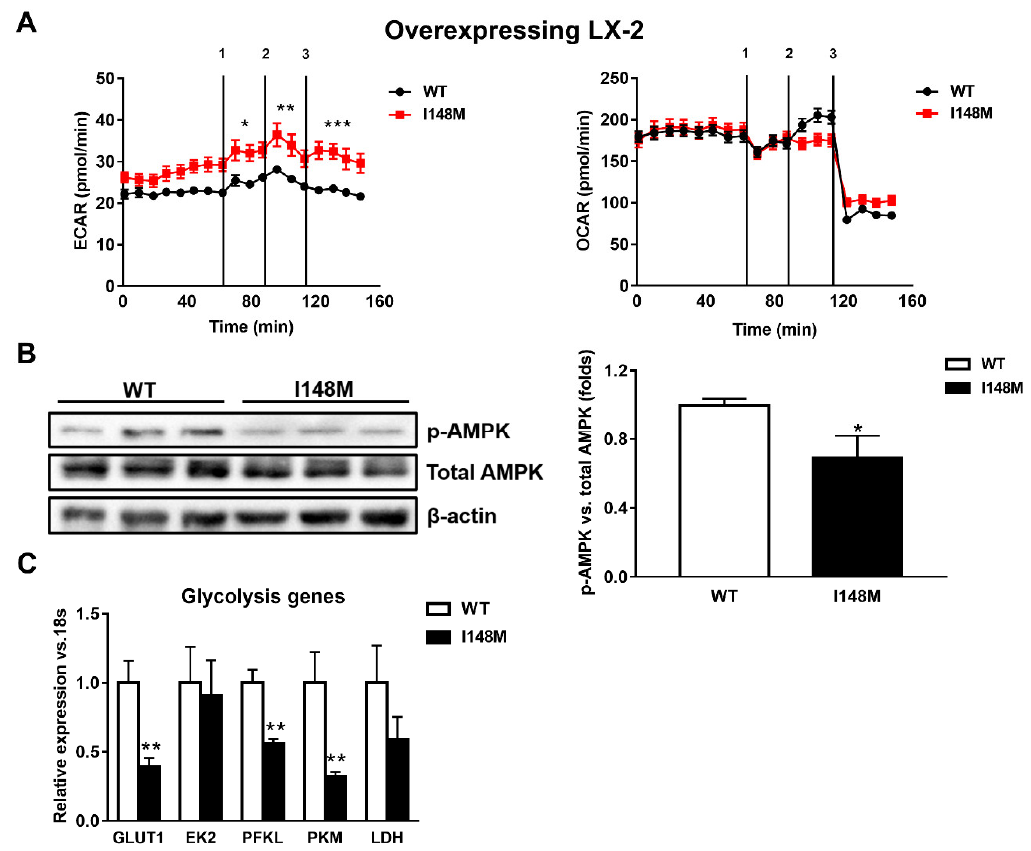
Figure 2. LX-2 with the PNPLA3 genetic variant shows activated anaerobic glycolysis. LX-2 stably overexpressing cells ( n = 3 each PNPLA3 genotype, WT or I148M) was obtained and cultivated in vitro, as described in Materials and Methods. ( A ) Lactate production (extracellular acidification rate (ECAR), pmol/min) and oxygen consumption rates (OCR, pmol/min) were measured in the culture medium, as described in Materials and Methods. * = p < 0.05, ** = p < 0.01, *** = p < 0.001 vs. WT cells. Separated injection of 1 = oligomycin; 2 = FCCP; and 3 = rotenone and antimycin A. ( B ) Representative blots of phospho-AMPK (p-AMPK) were performed on total protein extracts. Densitometry analysis was calculated using ImageJ software and data were normalized to β-actin. * = p < 0.05 vs. WT